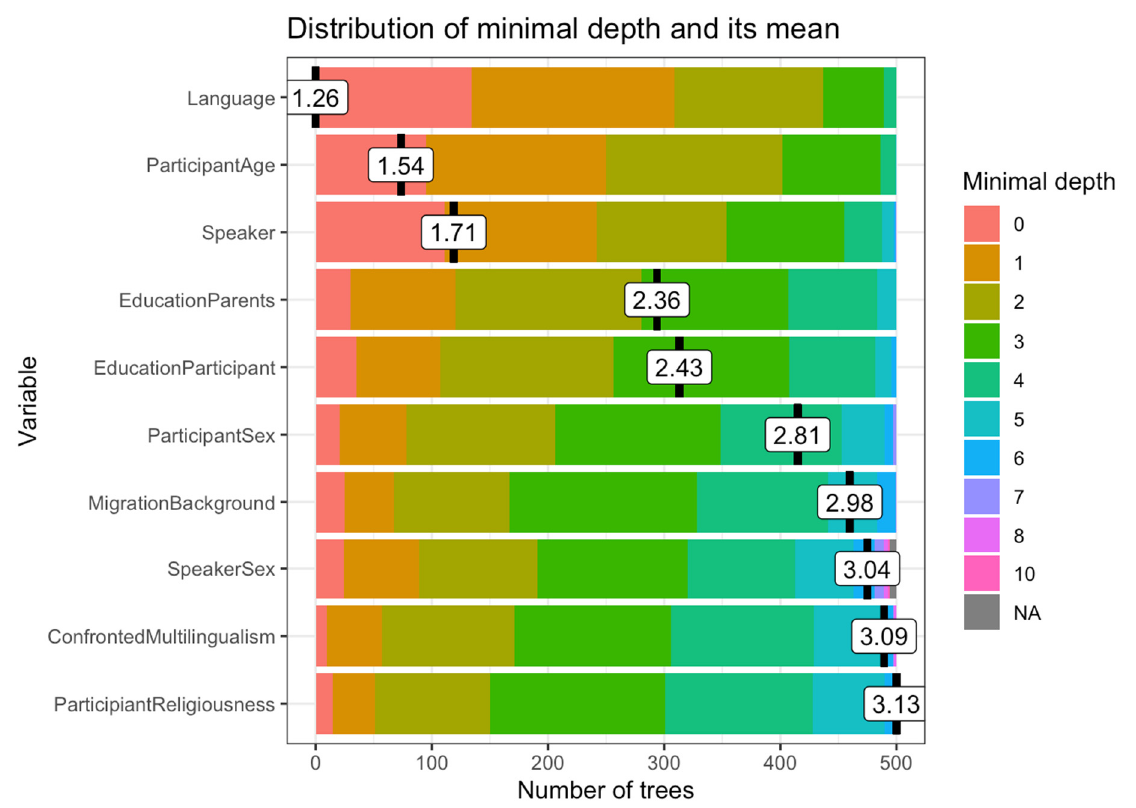
Figure 4. Random forest regression with 500 trees. Mean of squared residuals: 0.98. 28.3% of variance explained. The lower the minimal depth of a variable, the closer a variable is to the root of the tree, as shown in Figure 3, and the more observations were divided into groups on the basis of that variable.